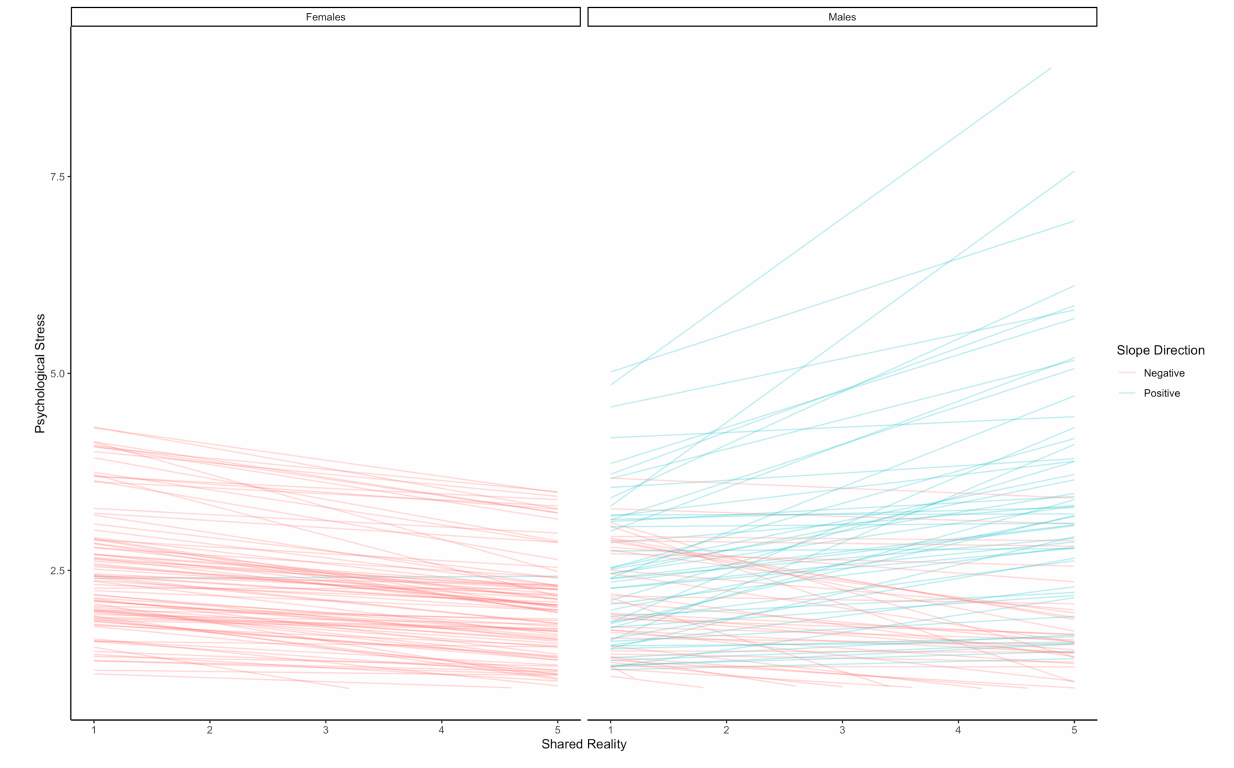
FIGURE 7 | Person-specific model predicted slopes for the effect of shared reality on psychological